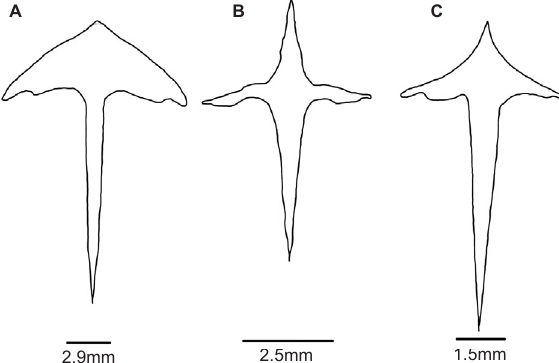
Figure 6. Ventral view of vomer: A - G. chindwinica (MUMF 9997), B - G. manipurensis (MUMF 4030) and C - G. ngapang (MUMF- 6141)